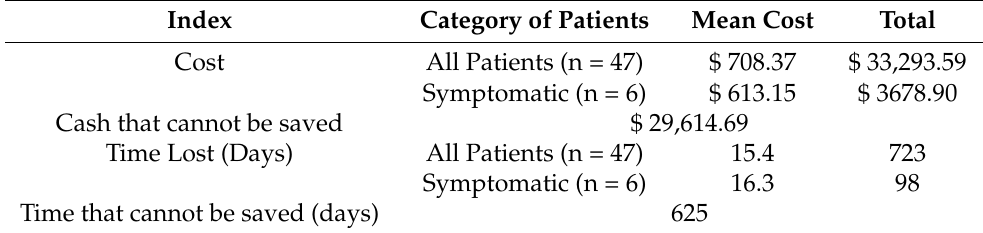
Table 11. Measured Economic Indices for Orthopaedic Implant